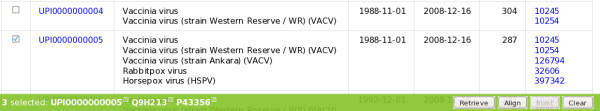
Using the cart to select items across multiple data sets.